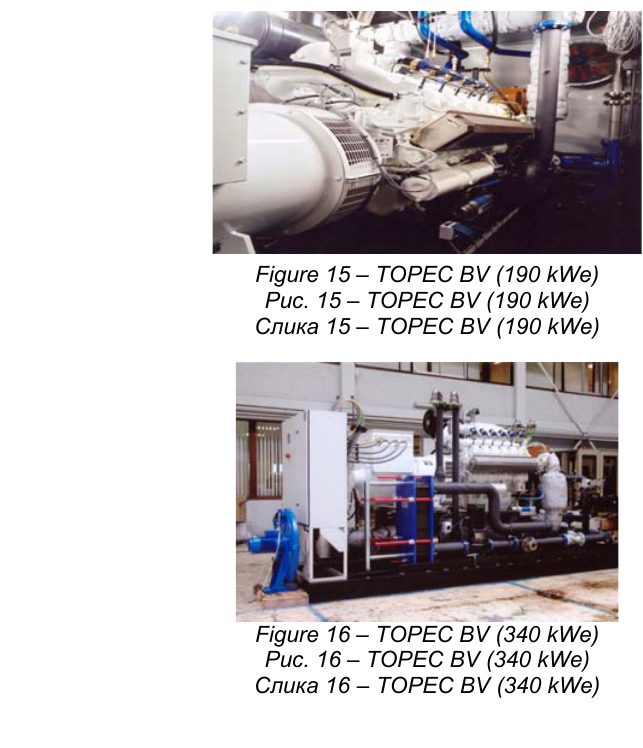
Figure 16 – TOPEC BV (340 kWe) Рис . 16 – TOPEC BV (340 kWe) Слика 16 – TOPEC BV (340